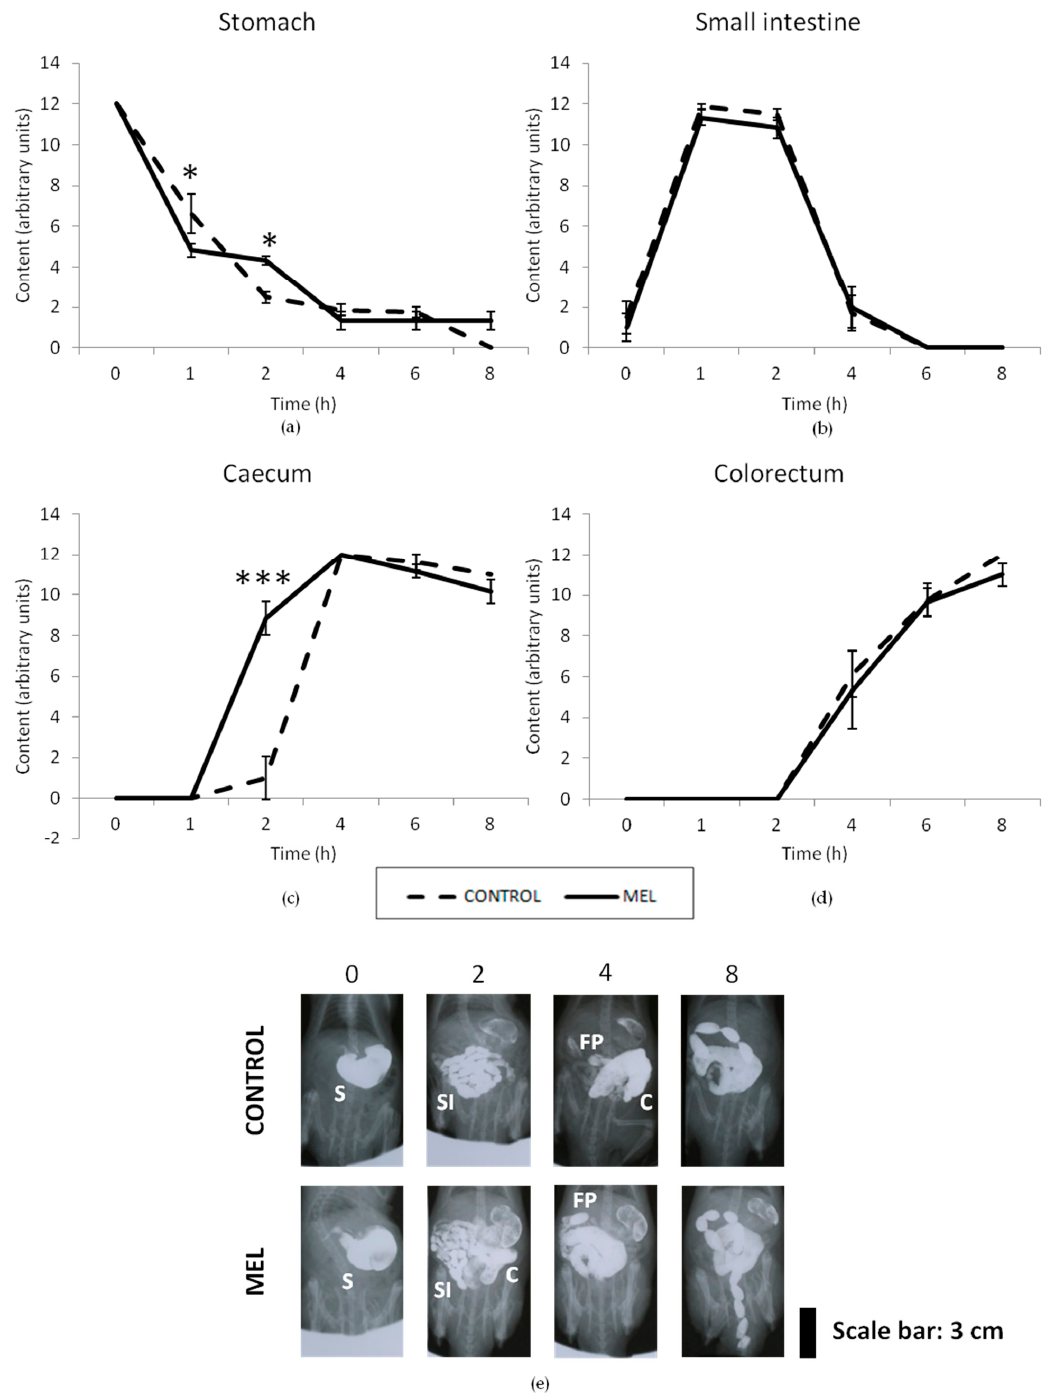
Figure 4. Radiological analysis of gastrointestinal motor function in rats—a semiquantitative analysis. A dose of barium sulfate (3 mL, 2 g/mL) was intragastrically administered at time 0, and X-rays were taken immediately and 1, 2, 4, 6, and 8 h, after administration. Motility curves for the stomach ( a ), small intestine ( b ), caecum ( c ), and colorectum ( d ) were obtained from the control rats ( n = 8) and rats treated with MEL (4 g/L) ( n = 6). Data represent the mean ± SEM. * p < 0.05, *** p < 0.001 (Two-way ANOVA followed by Bonferroni post-hoc test). Representative X-rays ( e ) obtained from a control and a MEL-treated rat at 0, 2, 4, and 8 h, after administration of barium sulfate. S—stomach; SI—small intestine; C—caecum; FP—fecal pellets (within the